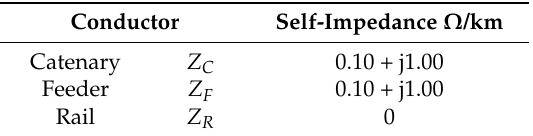
Table 3. Experimental setup impedance values of railway conductors.